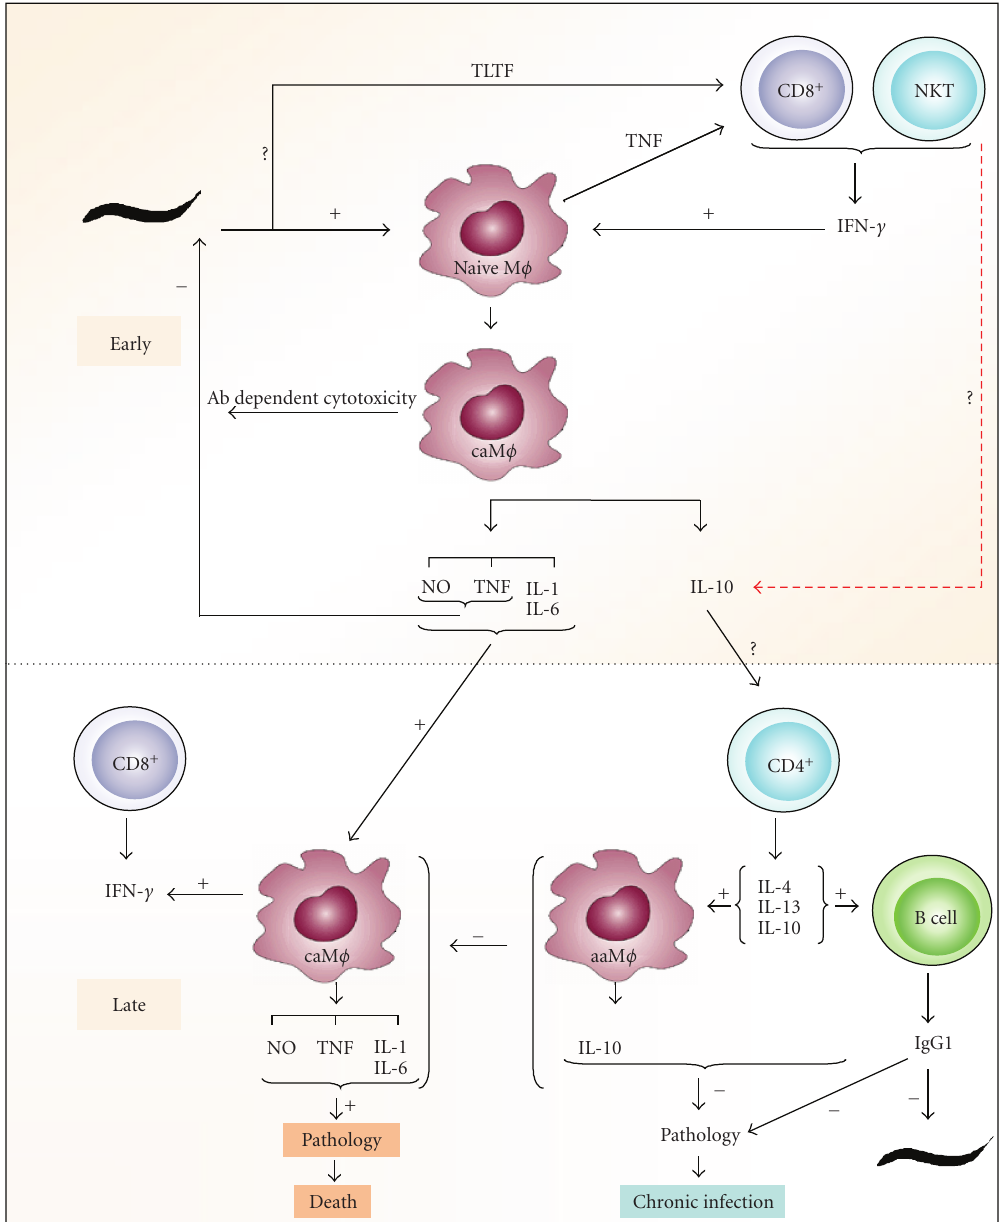
Figure 4: Trypanosome-host interaction (from [208]) . Model for induction classical (caM φ ) and alternative activation (caM φ ) of macrophages during trypanosome infection; TLTF: trypanosome-derived lymphocyte-triggering